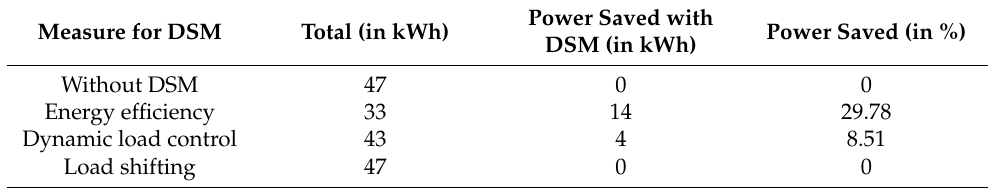
Table 1. Load profile before and after DSM for households in Bangladesh adapted from [38]. Measure for DSM Total (in